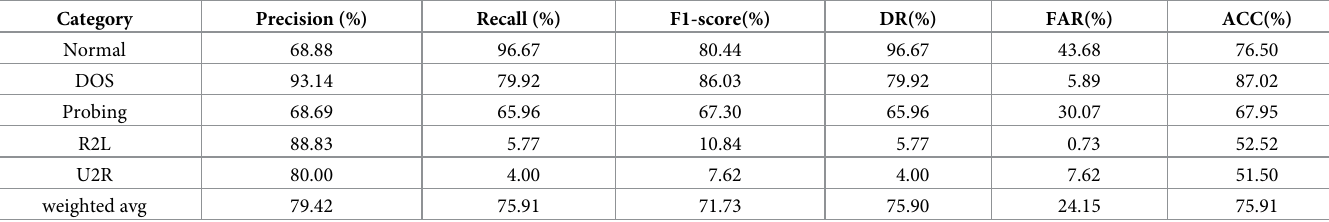
Table 6. Experimental results for different performance metrics in five categories of the KDDTest+ dataset.